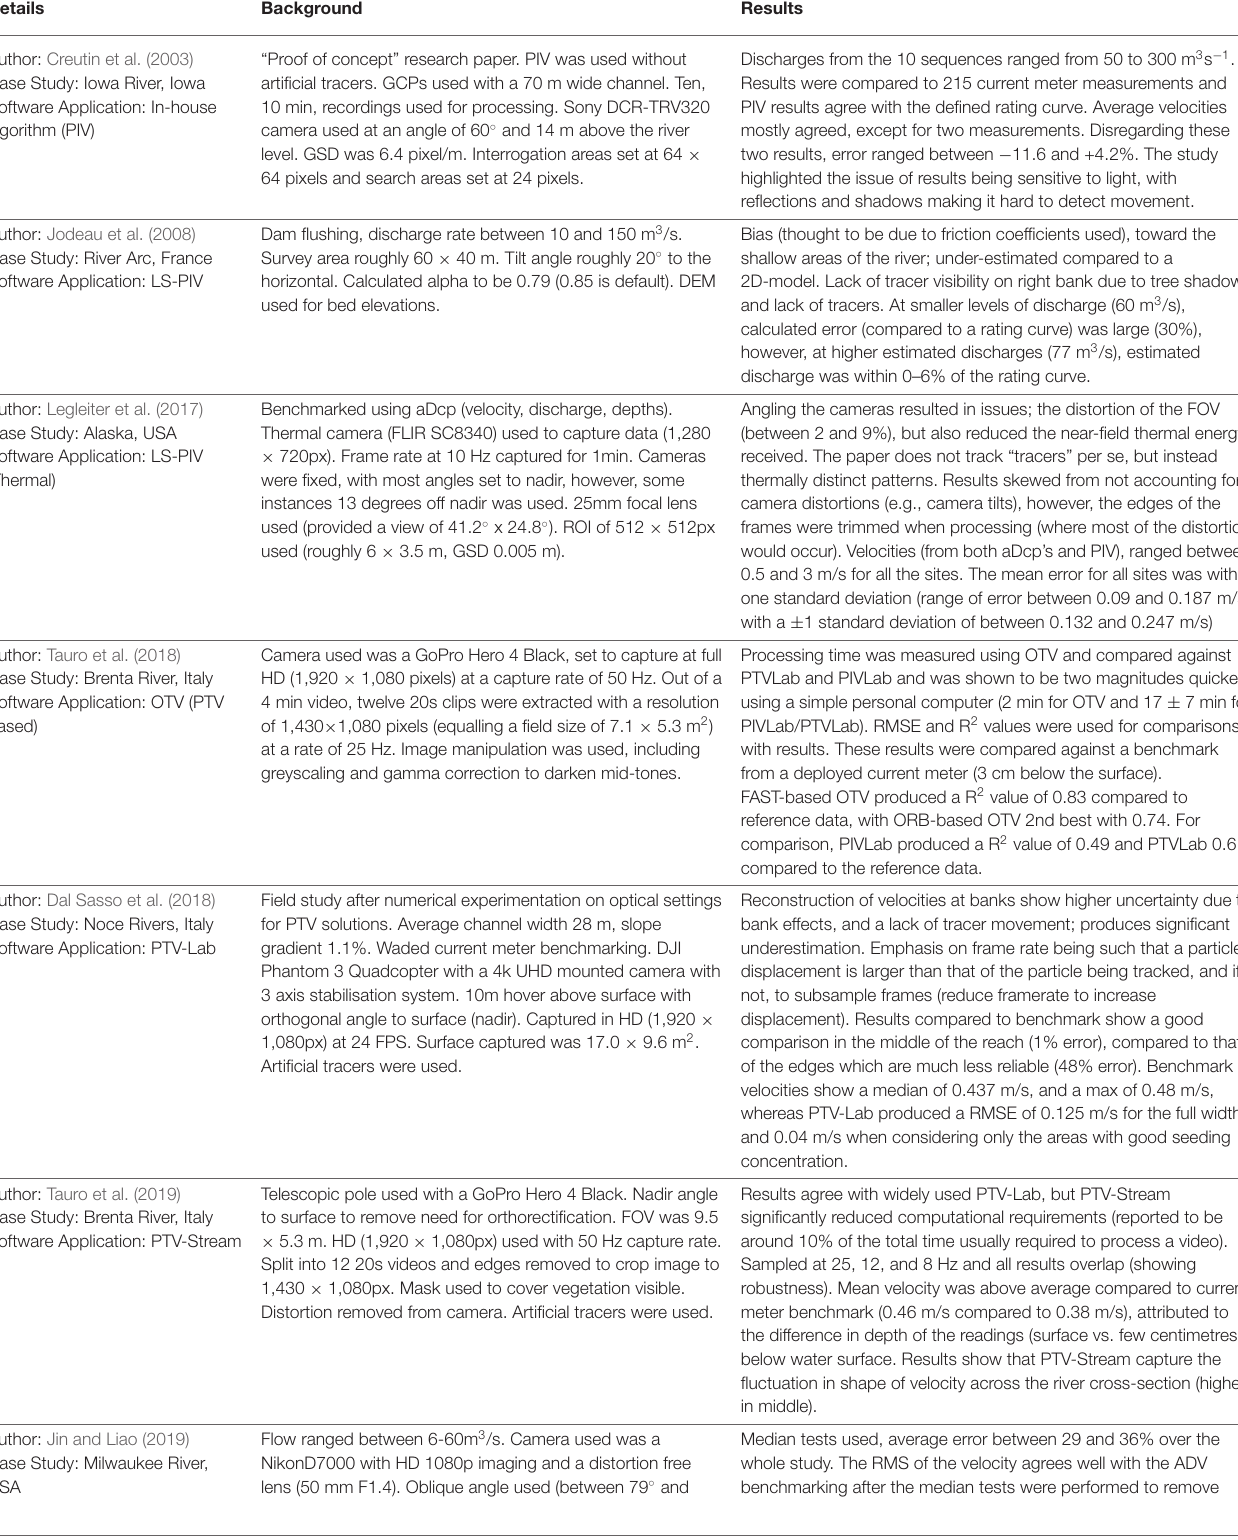
TABLE 2 | A selection of application papers chosen due to their variation of hardware and software